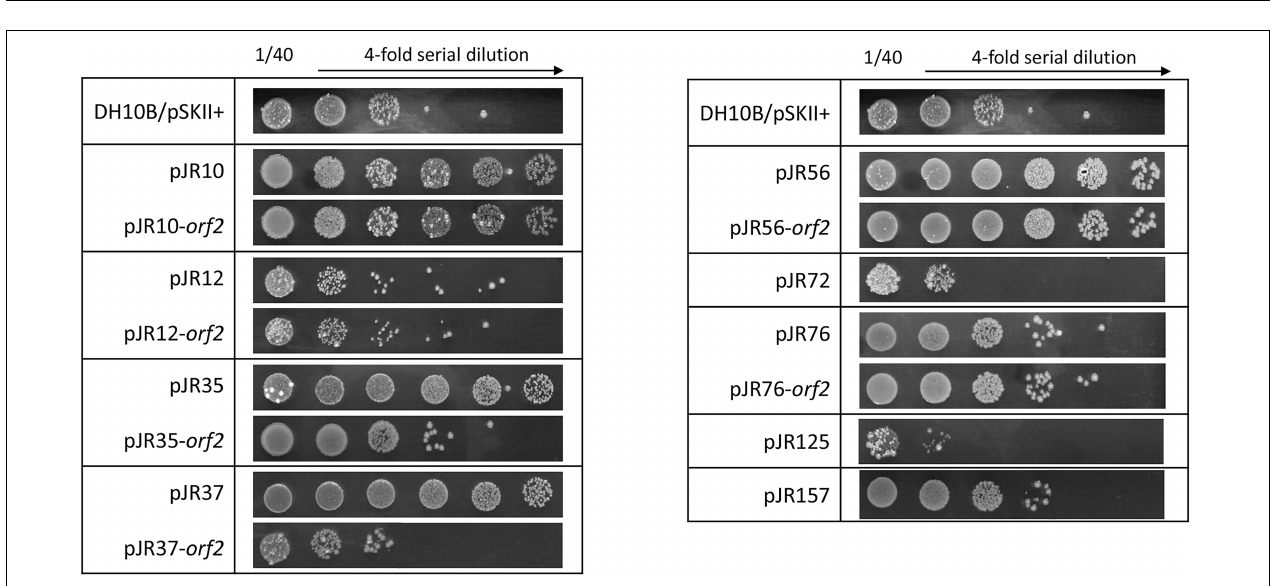
FIGURE 4 | UV-B resistance test by drop assays of the individual predicted ORFs involved in perchlorate resistance and their complete clones. Cultures were grown overnight at 37 ◦ C, drops of 4-fold serial dilutions were plated on LB-Ap and plates were incubated for 24 h after exposure to 20 s of UV-B (312 nm) radiation at 2 W m − 2 .